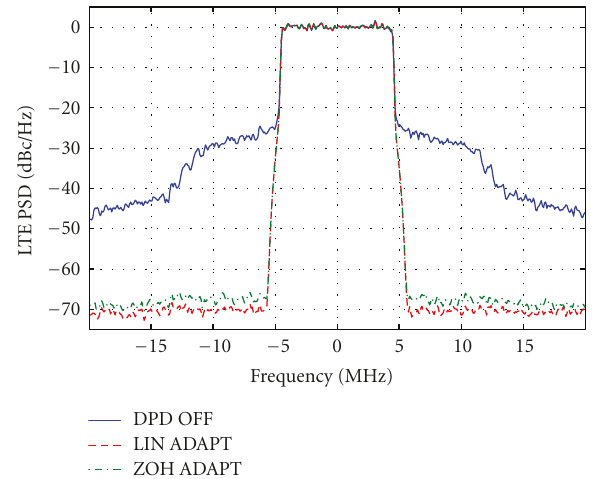
Figure 11: PSD performance of a complex-gain LUT predistorter trained using LCNLMS with linear (LIN) and nearest-neighbor (ZOH) interpolation in the feedback predistorter. Input waveform is a 10 MHz LTE OFDM